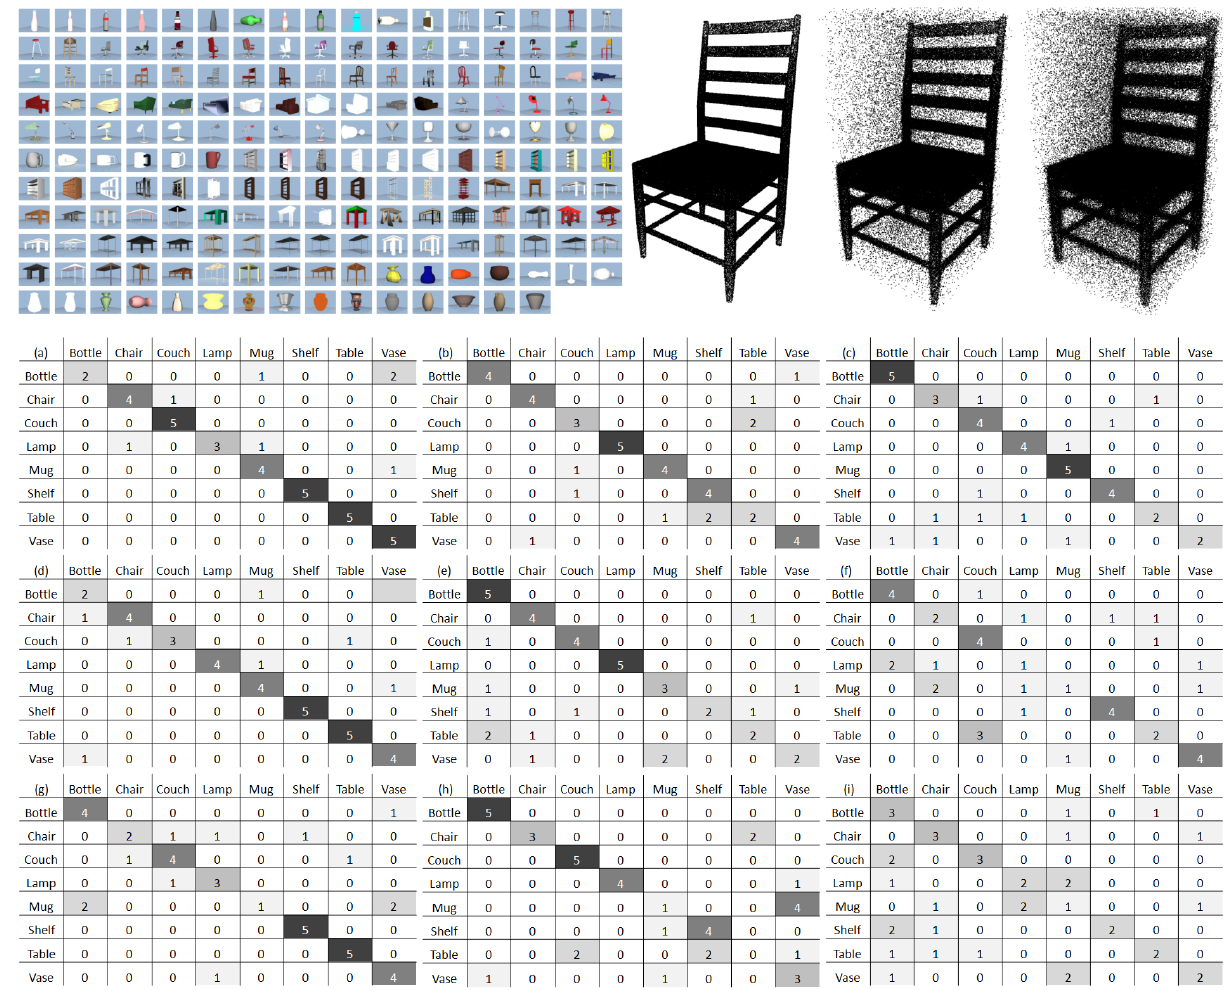
Figure 4: Benchmark. We compared the performance of our method with the performance of the D2 by Osada et al. (Osada et al., 2002) and ESF by Wohlkinger et al. (Wohlkinger and Vincze, 2011) shape descriptors on a subset of the Princeton Shape Benchmark (The Princeton Shape Benchmark, 2004) (top left) with different added amounts of noise and outliers (top right) . The results of each method are shown as confusion matrices in the columns: ours (left) , D2 (mid) , ESF (right) under added defects in the rows: no added defects (top) , 0 . 5% noise and 10% outliers (mid) , 1% noise and 20% outliers (bottom). The classification results are displayed in the columns versus the reference classes in the rows. The precision of our method is (a) 82 , 5% without added defects, (d) 77 , 5% with some defects and (g) 70% with more defects. The D2 shape descriptor by Osada et al. (Osada et al., 2002) performs with (b) 75% , (e) 67 , 5% and (h) 62 , 5% respectively. The ESF shape descriptor reveals more sensitive to noise and outliers as the precision drops quickly with increasing amounts of defects: (c) 72 , 5% , (f) 55% and (i) 45% . Shape Benchmark, 2004), see Fig. 4. A subset of the full dataset is used as many objects do not belong to the indoor